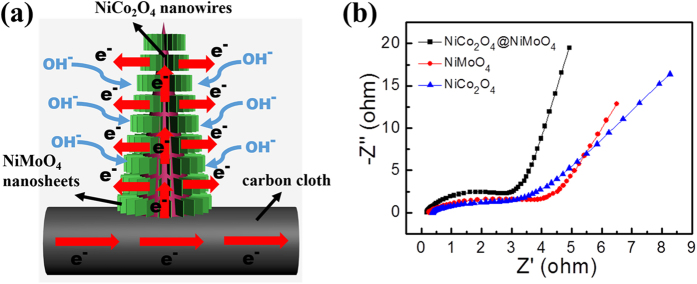
(a) Schematic transport and redox reaction process of electrons and ions in CC@NiCo2O4@NiMoO4 integrated electrode. (b) Electrochemical impedance spectra of CC@NiCo2O4@NiMoO4, CC@NiCo2O4 and CC@ NiMoO4 integrated electrodes.